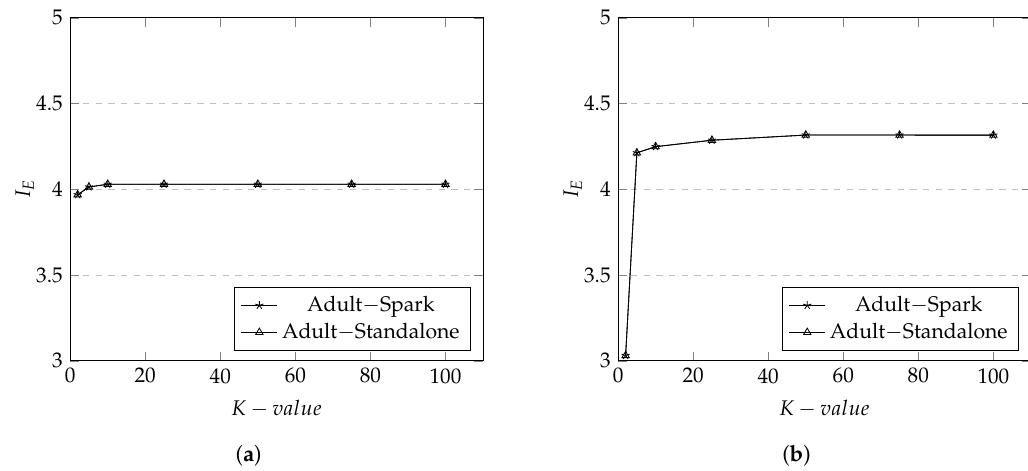
Figure 7. Information Entropy for Adult and Irish datasets on both Spark and Standalone. ( a ) I E in Adult Dataset; ( b ) I E in Irish